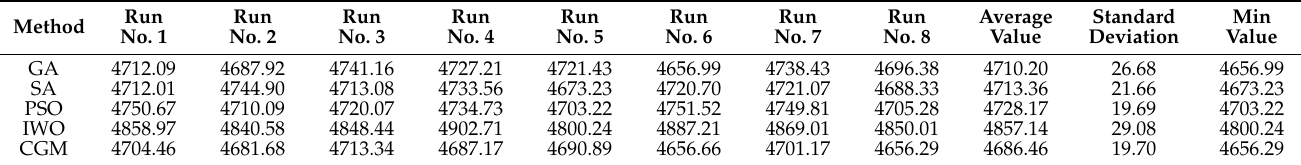
Figure 7. Route between cities after the execution of the CGM mechanism for ATT48 dataset: ( a ) iteration No. 1 and ( b ) iteration No. 300. Table 5. Results of several runs of all optimization algorithms on a single configuration for the traveling salesman problem.